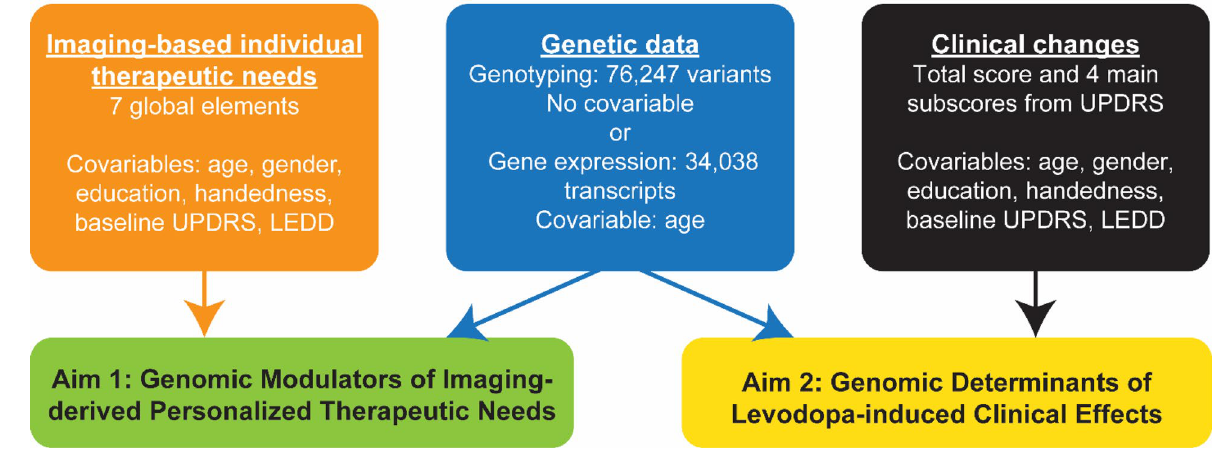
Figure 2. Schematics for determining causal genetic determinants of individual therapeutic needs and treatment response in PD. Two main analyses are performed: PLS-SVD on genetic data vs imaging-based individual therapeutic needs and genetic data vs clinical changes. [UPDRS = the Unified Parkinson’s Disease Rating Scale part III (ON medication), LEDD = levodopa equivalent daily dose].